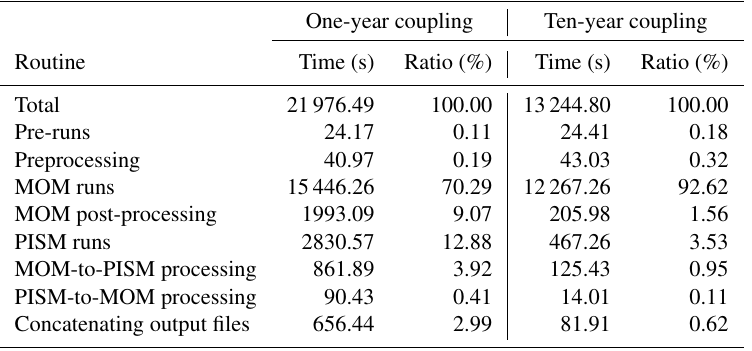
Table A1. Runtimes of the coupled PISM–MOM5 set-up for 200 years of model time using 32 cores. PISM runtimes include PICO, and MOM5 runtimes include SIS and FMS